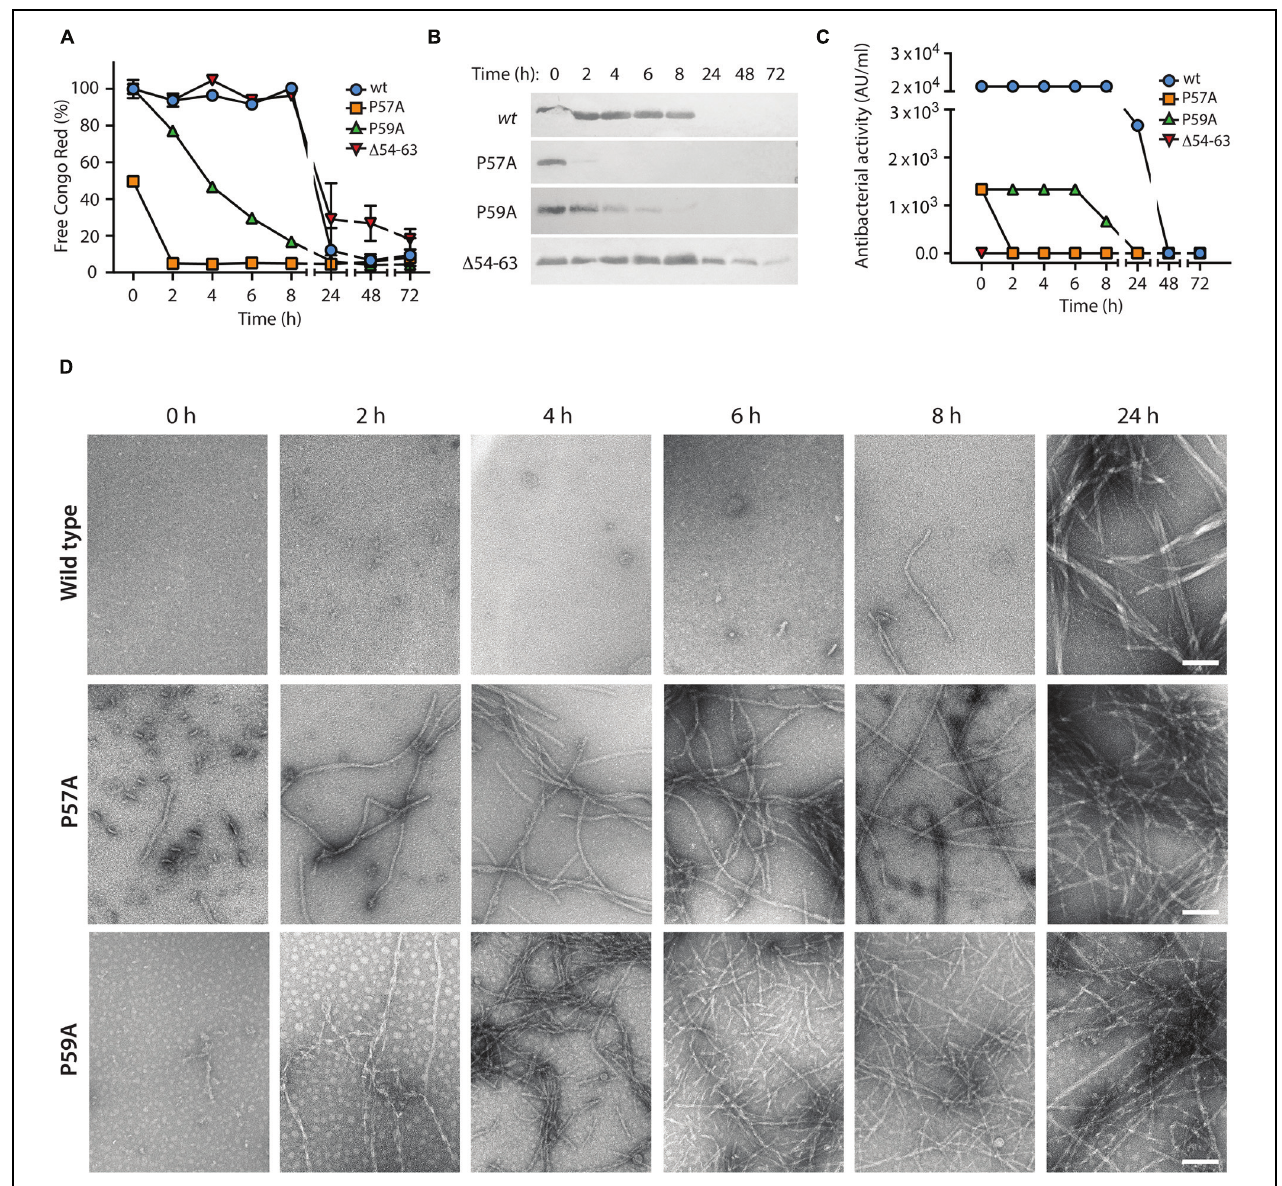
FIGURE 6 | In vitro amyloid polymerization of MccE492 variants with altered aggregation propensity. MccE492 variants (0.4 mg/ml) were incubated in aggregation buffer (see Materials and Methods) and the polymerization progress was evaluated during the time using Congo red binding (A) , and visualizing the remaining soluble MccE492 (after centrifuging the samples at 16000 × g during 40 min) through SDS-PAGE- Immunoblot (B) . In addition, the antibacterial activity was determined at each time (C) , and the morphology of the fibrils was studied by negative-stain electron microscopy (D) . Error bars show the standard deviation from three independent experiments. Scale bar: 100